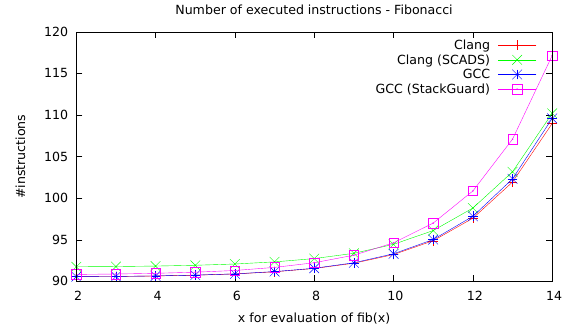
Figure 12. Number of executed instructions when running the program defined by listing 17.